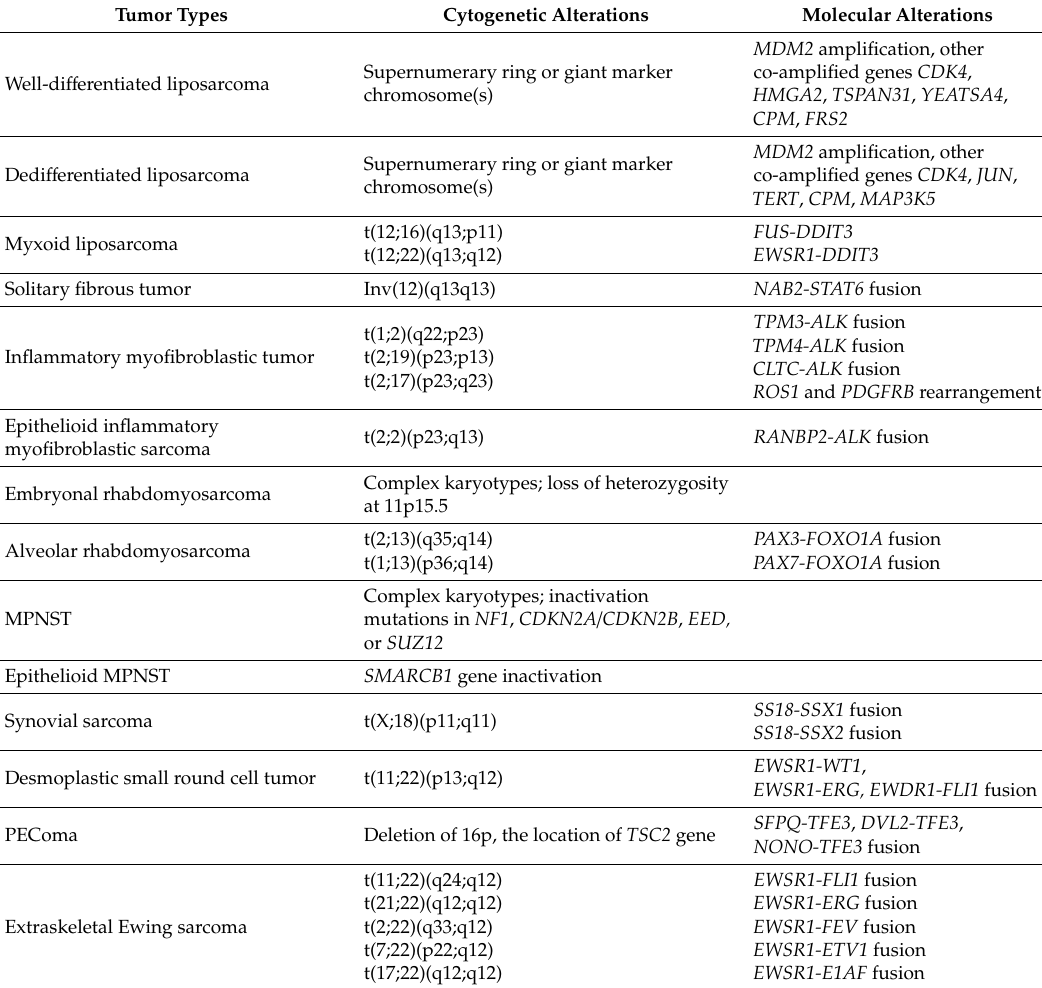
Table 4. Cytogenetic and molecular alterations in selected retroperitoneal mesenchymal